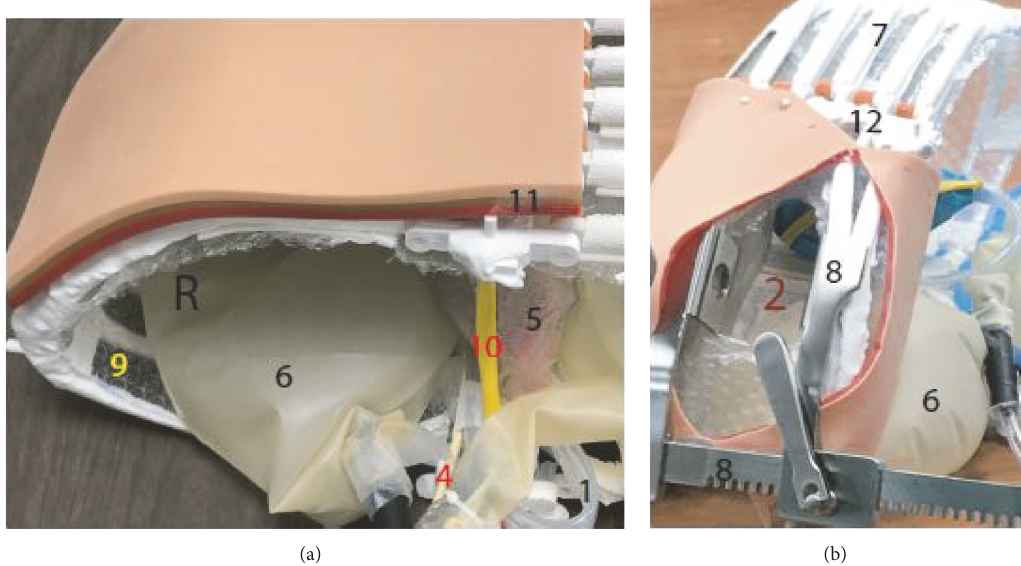
Figure 2: 1= Aorta. 2= Chest cavity. 3= Diaphragm. 4= Esophagus. 5= Heart with pericardium. 6= Lung. 7= Rib. 8= Rib spreader. 9= Parietal pleura. 10= Phrenic nerve. 11= Skin with subcutaneous tissue and chest wall muscle. 12= Sternum. 13= Trachea with main bronchi. L= left side. R= right